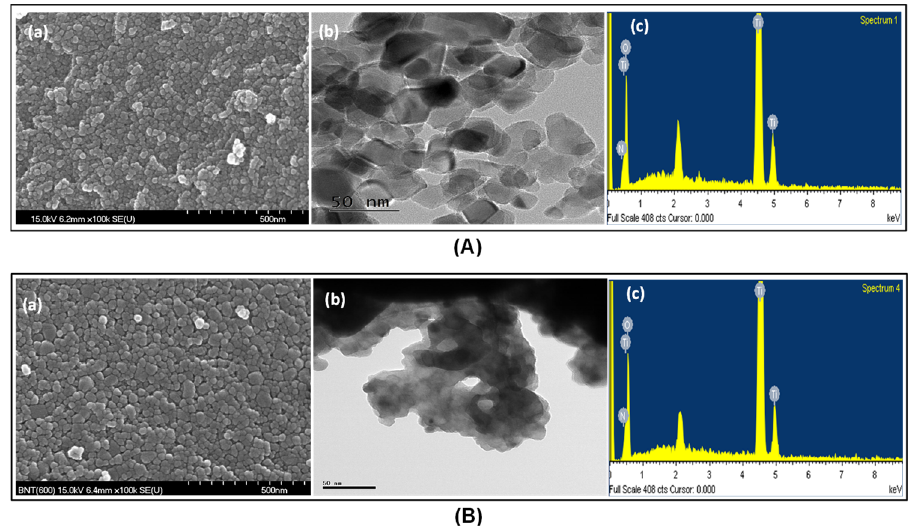
Figure 2. SEM-EDS and TEM images of ( A ) amorphous N/TiO 2 and ( B ) anatase N/TiO 2 : ( a )